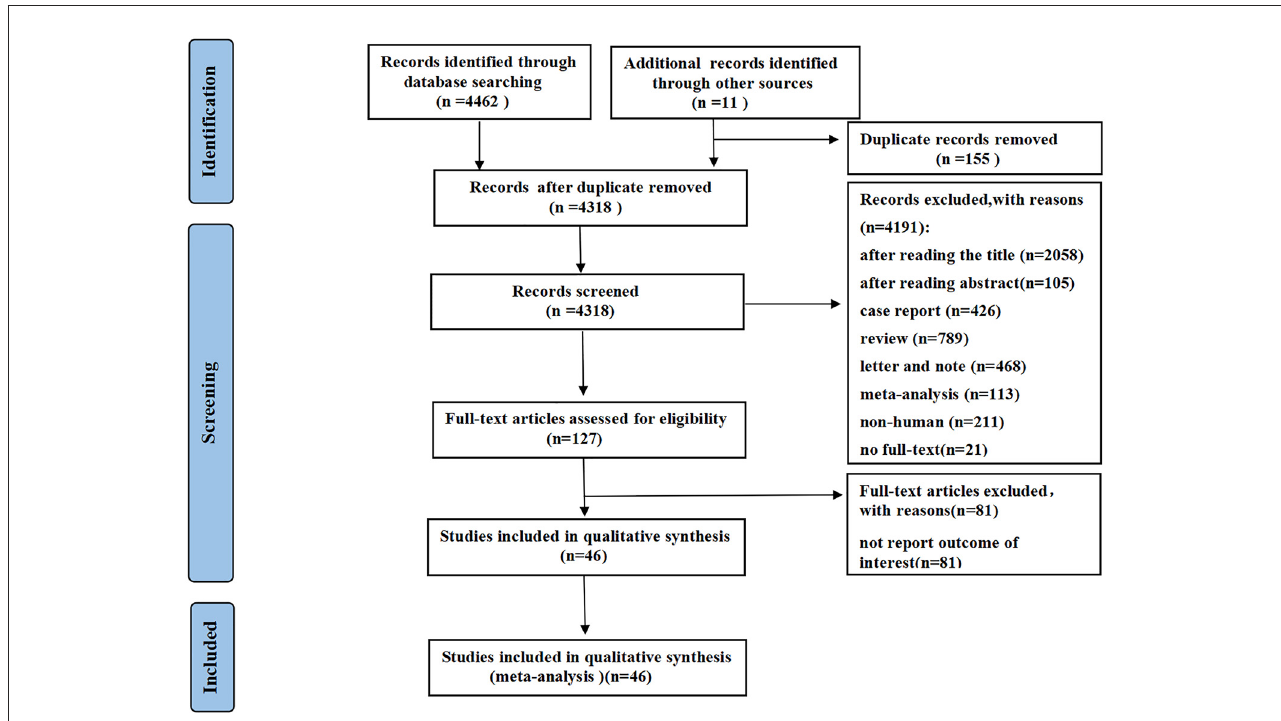
FIGURE1 Preferred reporting items for meta-analyses (PRISMA) flow diagram.